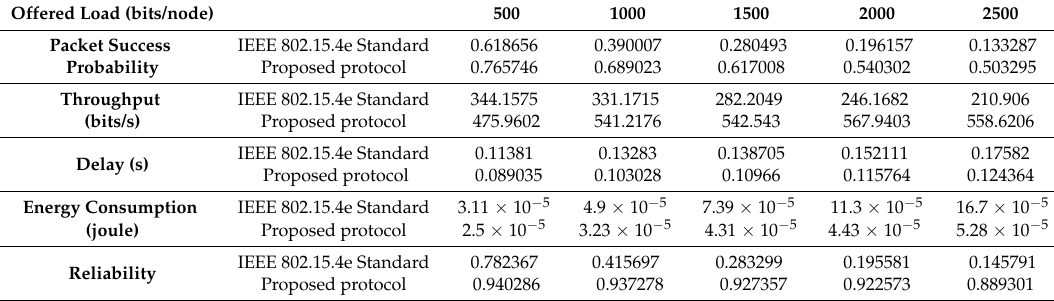
Table 3. Summarization of the obtained result of our protocol with the IEEE 802.15.4e